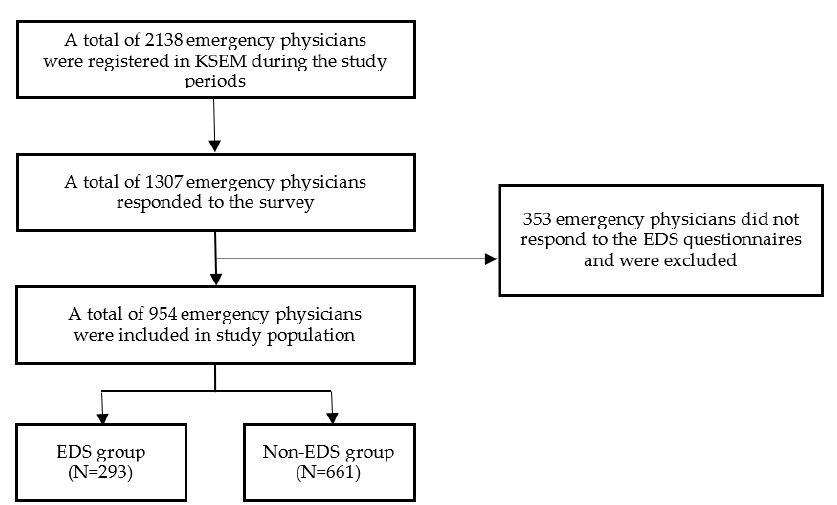
Figure 1. Flow chart of the study population. EDS = excessive daytime sleepiness.